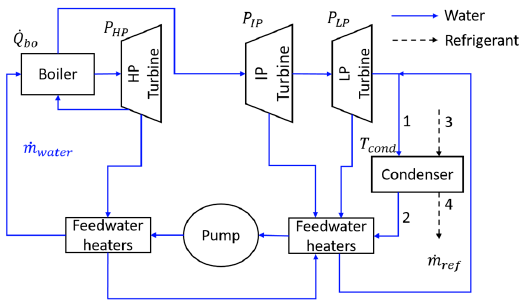
Figure 2. Schematic diagram of power plant model.